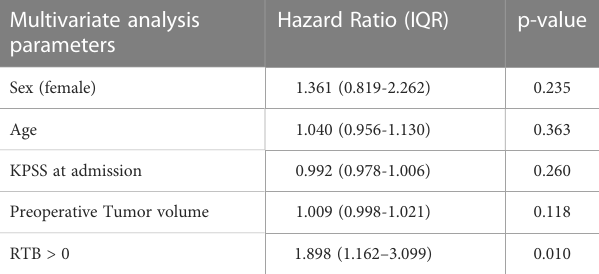
TABLE 2 Multivariate Cox regression analysis including the following risk factors for mortality: sex (female), age, KPSS at admission, preoperative tumor volume, and RTB >